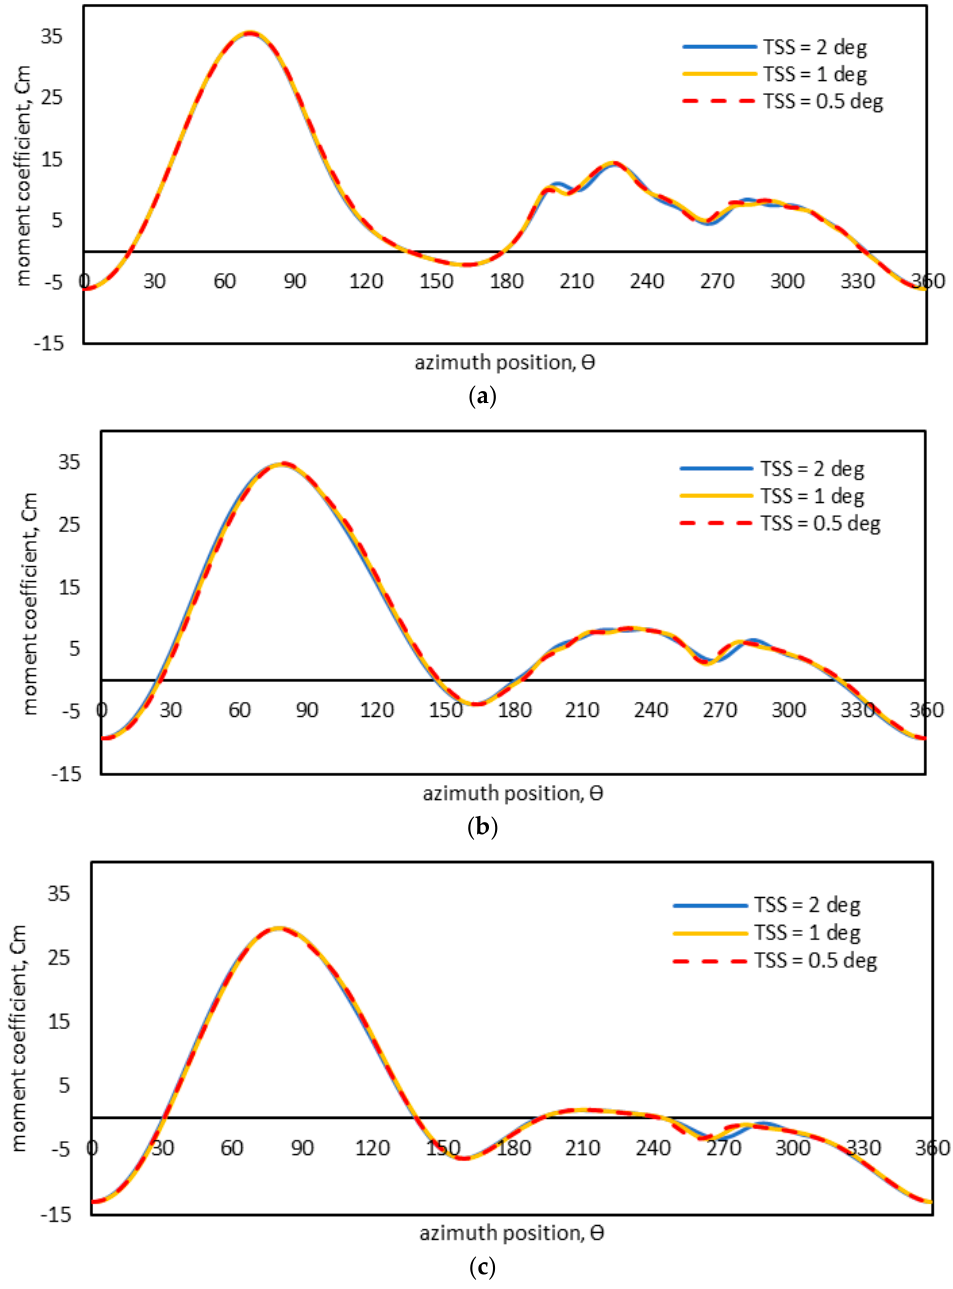
Figure 4. Time step size (TSS) study results on moment coefficient values for ( a ) λ = 3, ( b ) λ = 4 and ( c ) λ = 5.